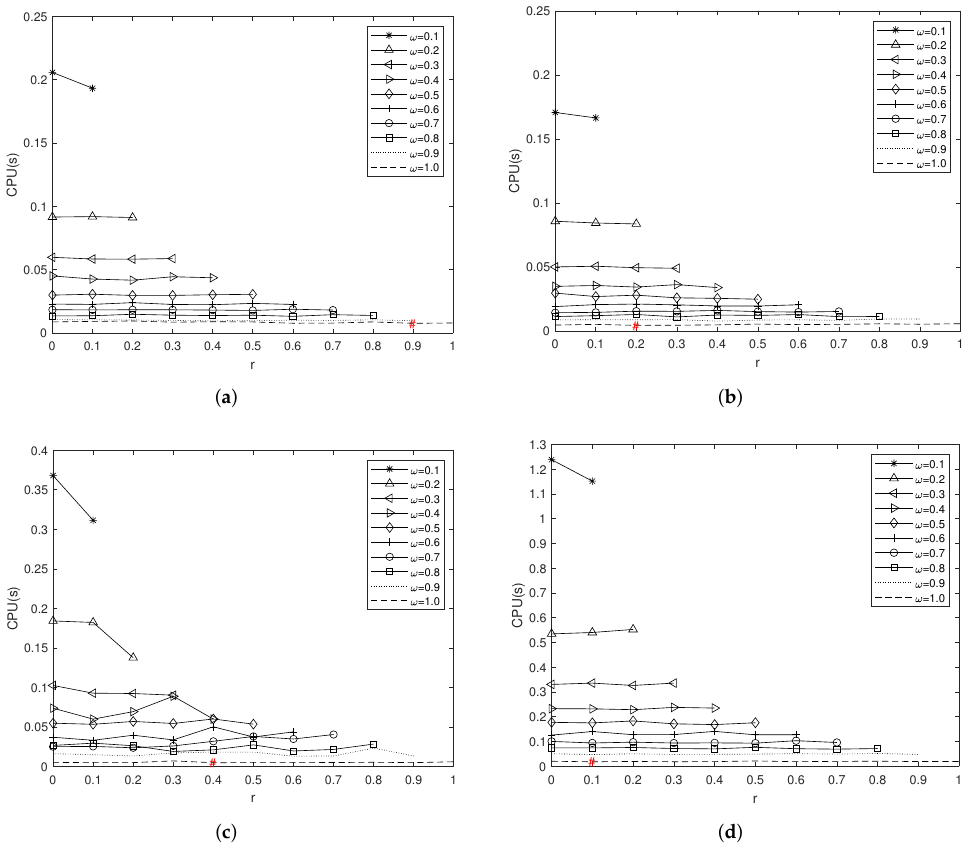
Figure 2. The numerical results of Example 3. ( a ) n = 4; ( b ) n = 10; ( c ) n = 30; ( d ) n = 50. Table 2. The numerical results of Example 3 with optimal parameters ω and